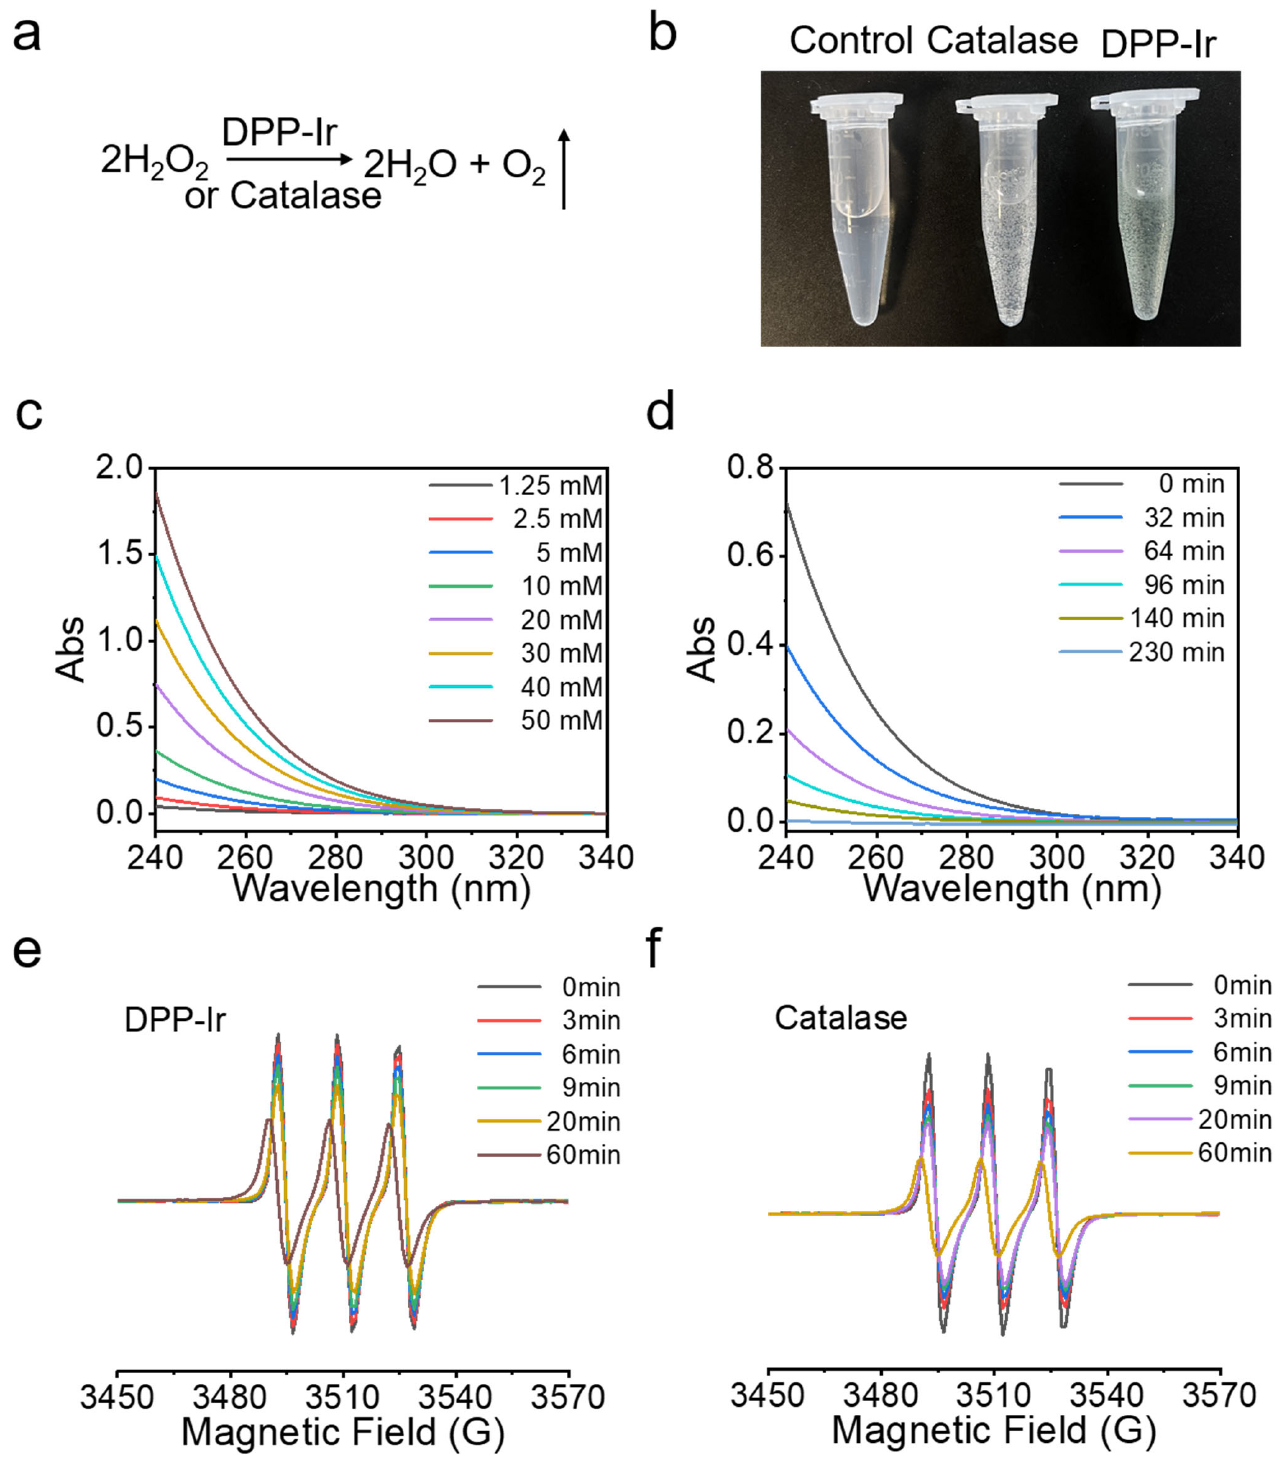
Figure 3. ( a ) H 2 O 2 decomposition formula. ( b ) The images of gas bubbles produced after incubation of H 2 O 2 with DPP-Ir/catalase in phosphate buffer (pH = 7.4) for 10 min, from left to right, are: control, 20 mM H 2 O 2 ; catalase, 2 U mL − 1 catalase + 20 mM H 2 O 2 ; DPP-Ir, 50 µ g mL − 1 DPP-Ir + 20 mM H 2 O 2 . ( c ) Absorption curves for different concentrations of H 2 O 2 . ( d ) Time-dependent UV–vis spectra of H 2 O 2 (20 mM) after the reaction with DPP-Ir nanoparticles (50 µ g mL − 1 , pH 7.4). The EPR signals of time-dependent oxygen production catalyzed using DPP-Ir nanoparticles (50 µ g mL − 1 ) and catalase (2 U mL − 1 ) at pH 7.4 are shown in ( e , f ), respectively.